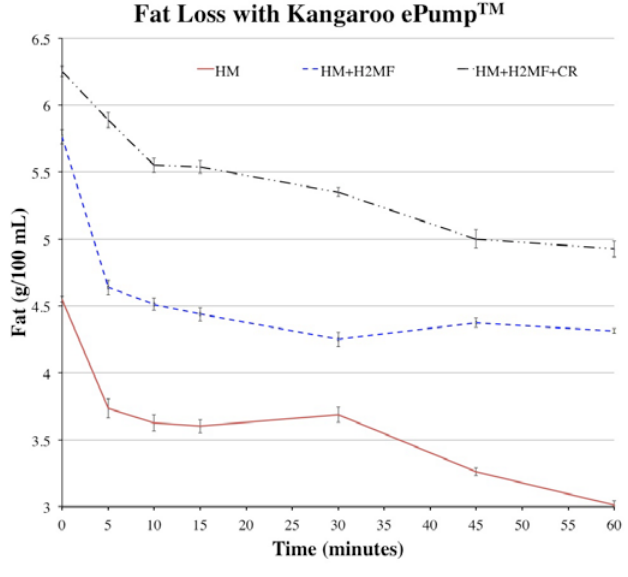
Figure 1. Fat values over one-hour feeds with HM, HM + H 2 MF, and HM + H 2 MF + cream with Kangaroo ePump™, HM: human milk; H 2 MF: HM supplemented with